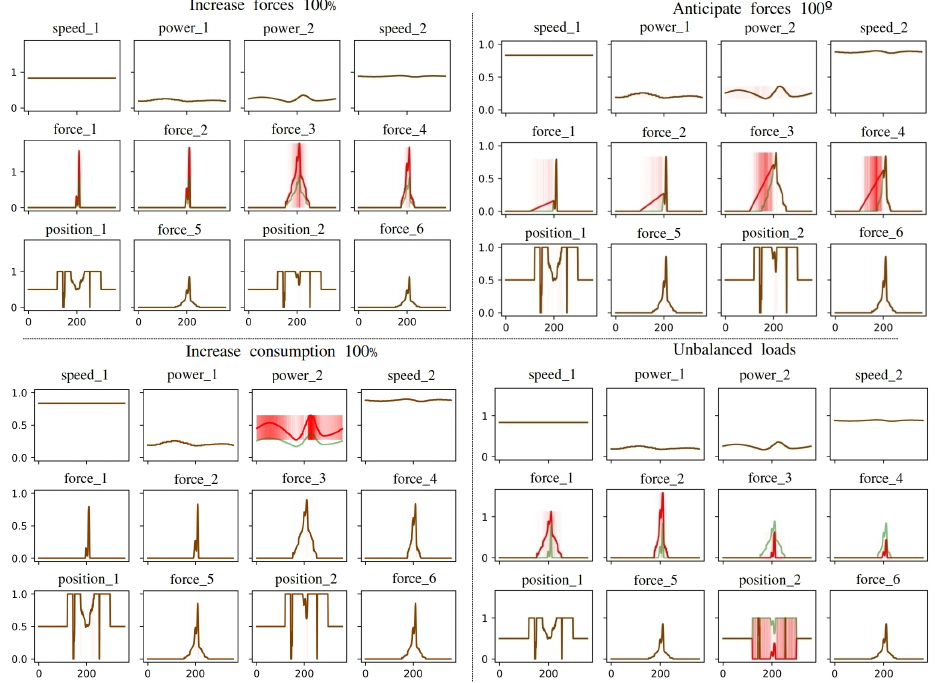
Figure 7. Diagnosis using XAI on the same stroke with 4 failure types, shadowing evolution variables’ points that cause them in red color.